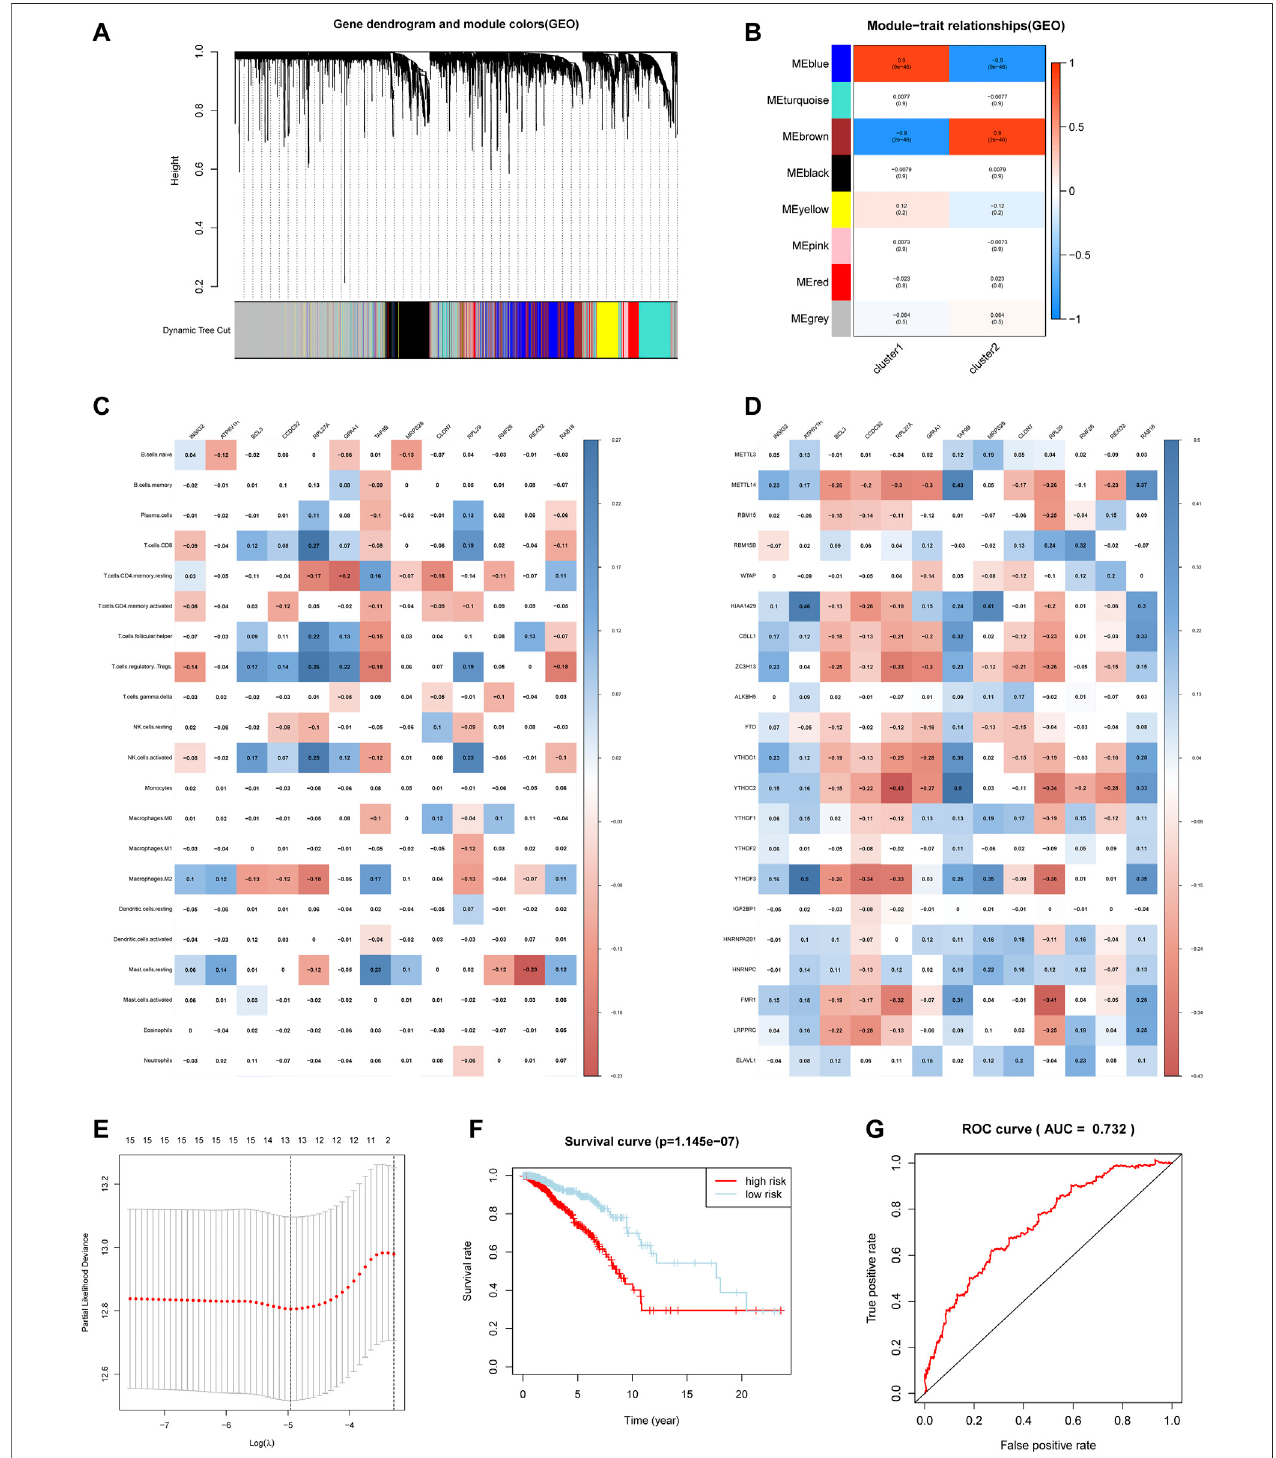
FIGURE 6 | Hub genes were signi fi cantly correlated with m6A regulators and immune in fi ltrating cells. (A) Clustering dendrograms of genes. (B) Module-trait associations. (C) Spearman correlation analysis between hub gene and 24 m6A regulators. (D) Spearman correlation analysis between hub gene and in fi ltrating immune cells. (E) The minimum mean value of the target parameter in the process of LASSO Cox regression. (F) The overall survival of the high and low m6aRiskscore groups. (G) The ROC curve veri fi es the accuracy of the risk model.